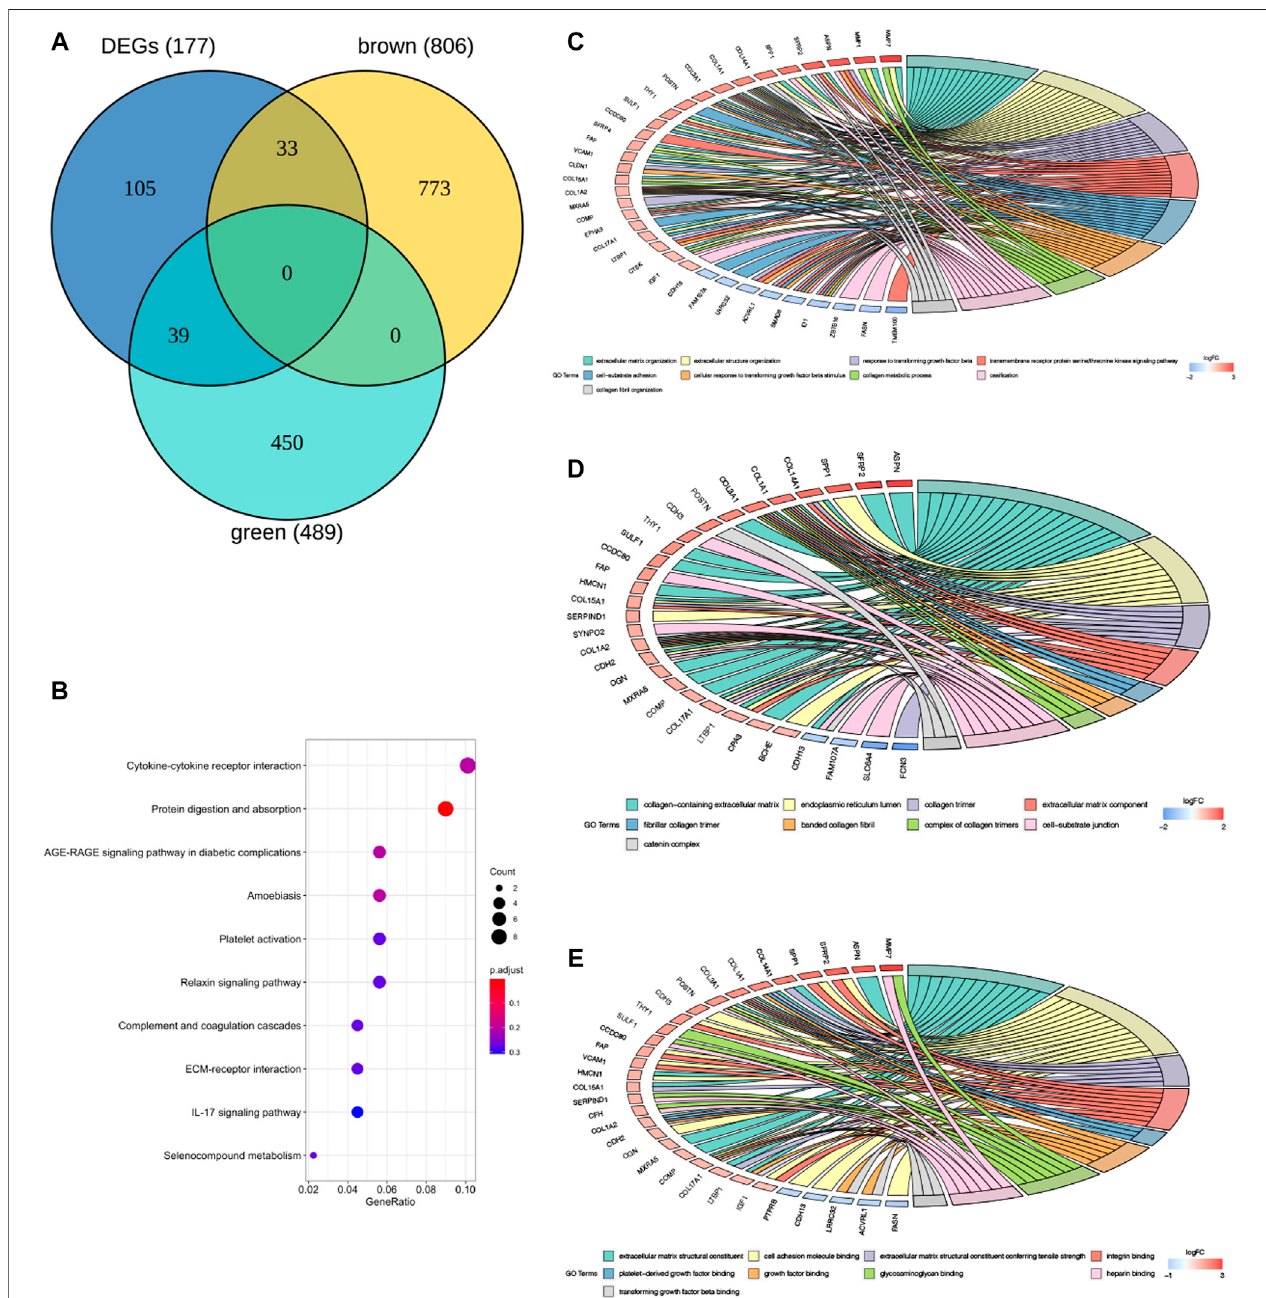
FIGURE 4 | GO and KEGG enrichment analysis of key genes in the training group. (A) The Venn diagram demonstrating key genes in the training group. (B) Kyoto encyclopediaofgenesandgenomes(KEGG)analysisofkeygenes (E) .Geneontology(GO)analysisofkeygenesinthetraininggroup (C – E) , (C) BP:biologicalprocess, (D) CC: cellular component, (E) MF: molecular